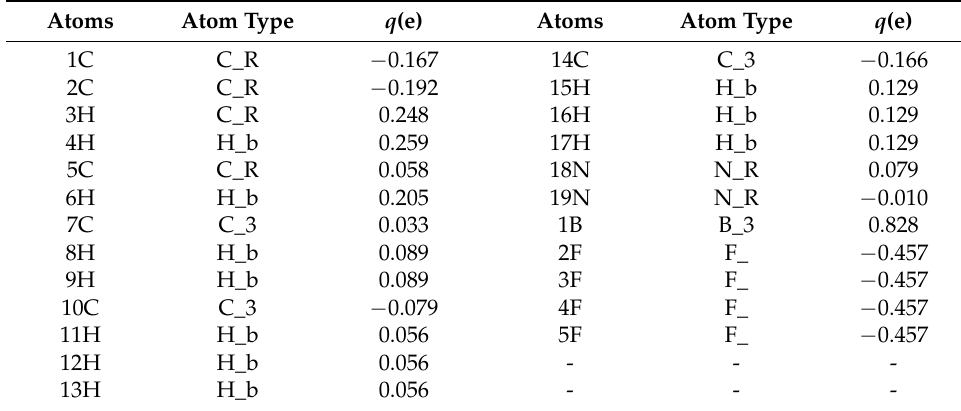
Table 1. Atom types and partial charges on the atoms of cation and